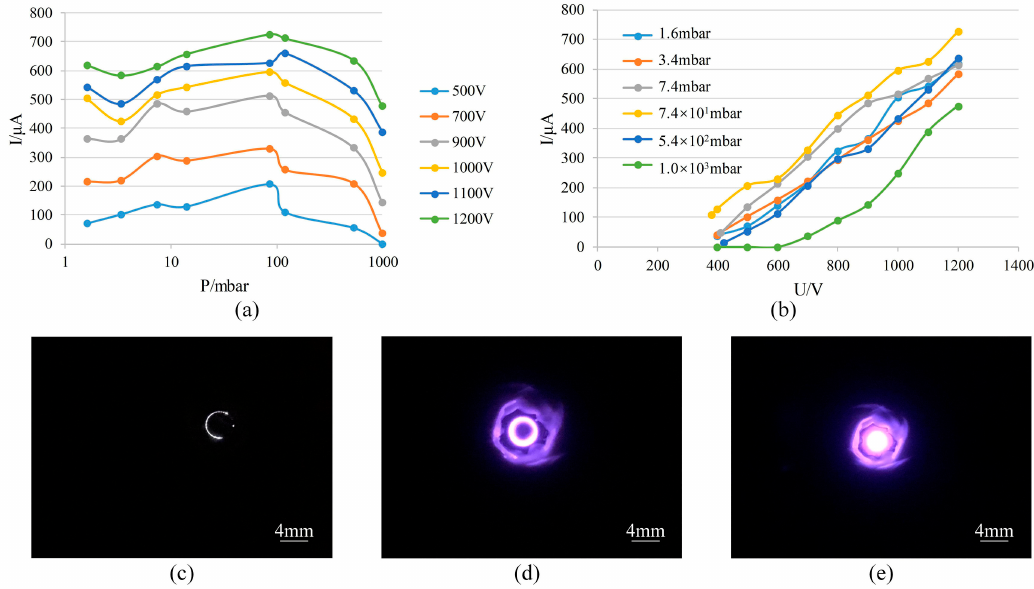
Figure 5. The measurement of the properties of the without-magnet ion source ( a , b ) and discharge pictures at different conditions ( c–e ): ( a ) discharge current vs. pressure; ( b ) discharge current vs. pictures at different conditions ( c – e ): ( a ) discharge current vs. pressure; ( b ) discharge current vs. voltage U; ( c ) p = 1 atm, U = 800V; ( d ) p = 14 mbar, U = 700V; ( e ) p = 7.4 mbar, U = 700V. voltage U; ( c ) p = 1 atm, U = 800 V; ( d ) p = 14 mbar, U = 700 V; ( e ) p = 7.4 mbar, U = 700